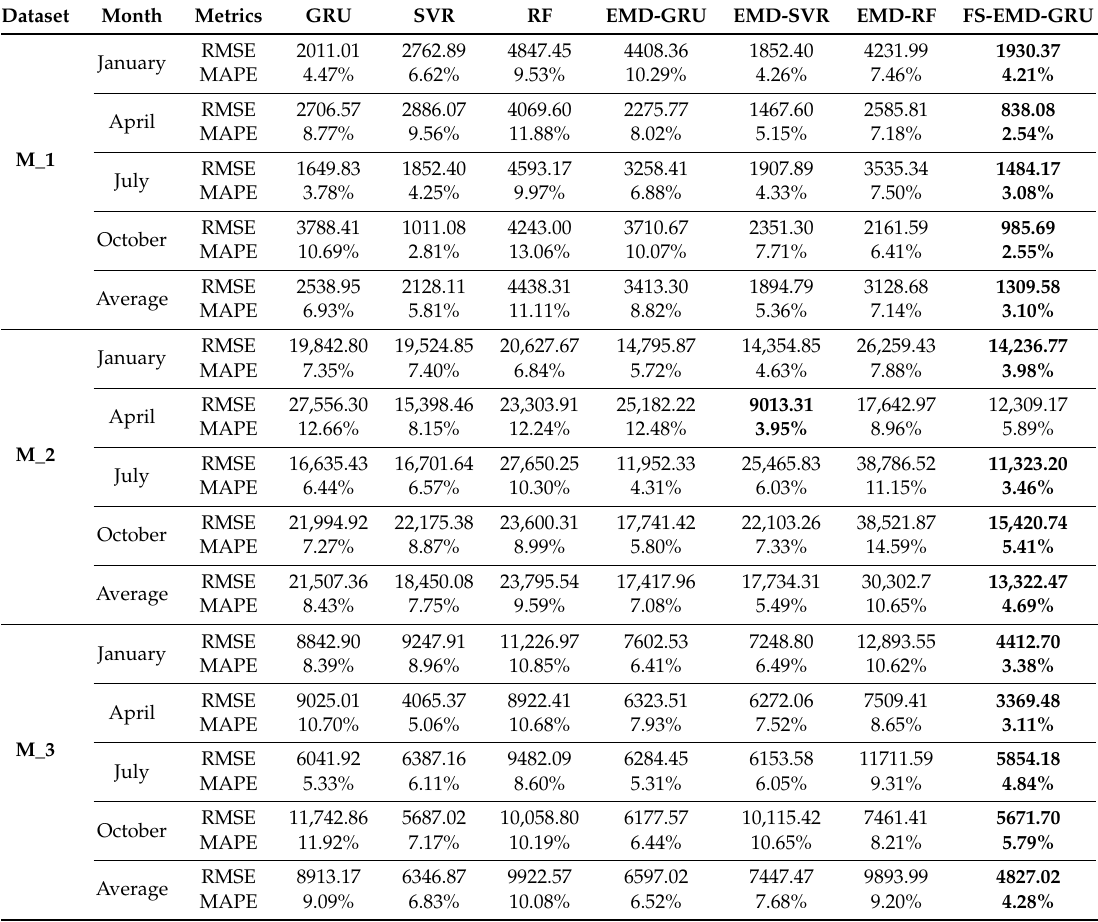
Table 3. Comparisons of predicted results for U.S.